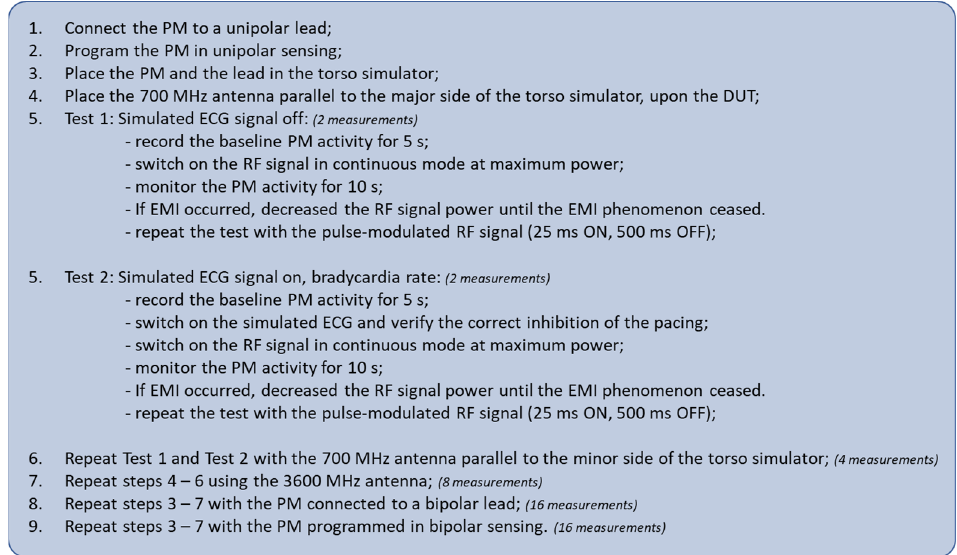
Figure 2. The flow chart of the test procedure followed for PM measurements. A total of 48 measurements for each PM were collected.